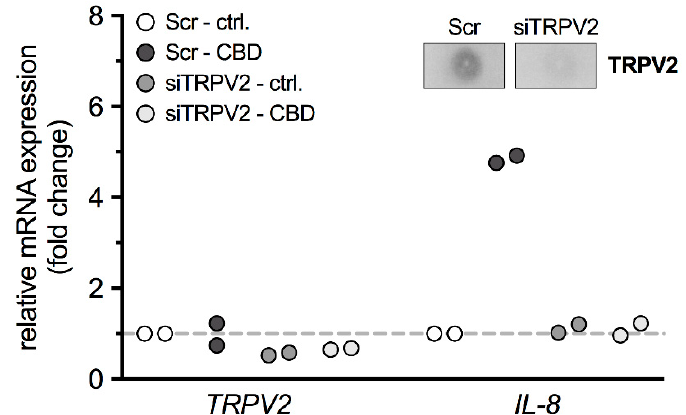
Figure 6. Transfection of HTPCs with a TRPV2 siRNA abolished the observed effects upon IL-8. Quantitative PCR data from HTPCs transfected with scrambled (Scr) non-targeting control siRNA or TRPV2 siRNA (siTRPV2) and treated with CBD (10 µM; Scr-CBD and siTRPV2-CBD) or equal volume of EtOH (Scr-ctrl. and siTRPV2-ctrl.) for 24 h. Upper panel shows a representative TRPV2 dot blot